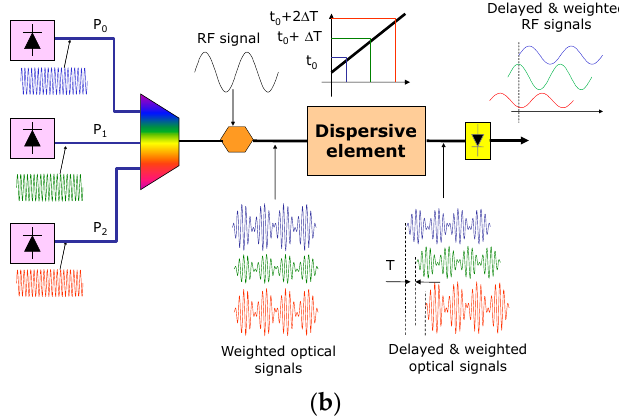
Figure 1. Generic implementations of an incoherent finite impulse response microwave photonic (MWP) filter, based on ( a ) a single wavelength optical source and ( b ) a multiple wavelength optical source.